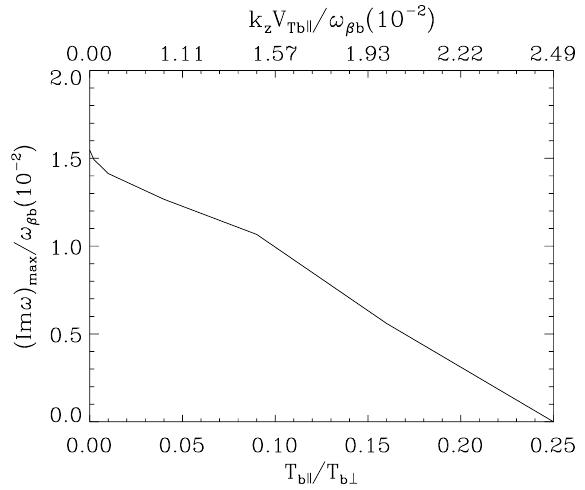
FIG. 8. The maximum linear growth rate (cid:1) Im v (cid:2) max of the electron-proton instability decreases as the longitudinal tempera- ture of the beam ions